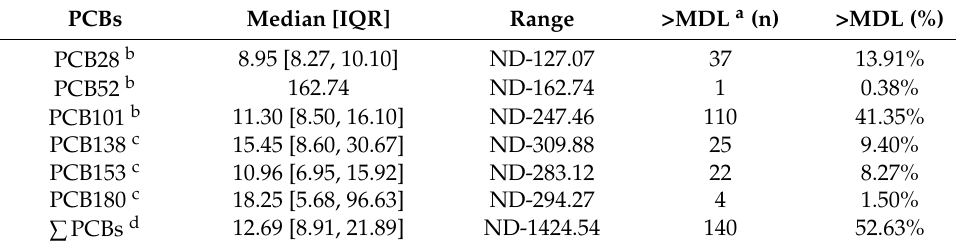
Table 2. Plasma PCBs levels (ng/g lipid) of the participant sample (N =266). PCBs Median [IQR] Range >MDL a (n) >MDL (%) PCB28 b 8.95 [8.27,